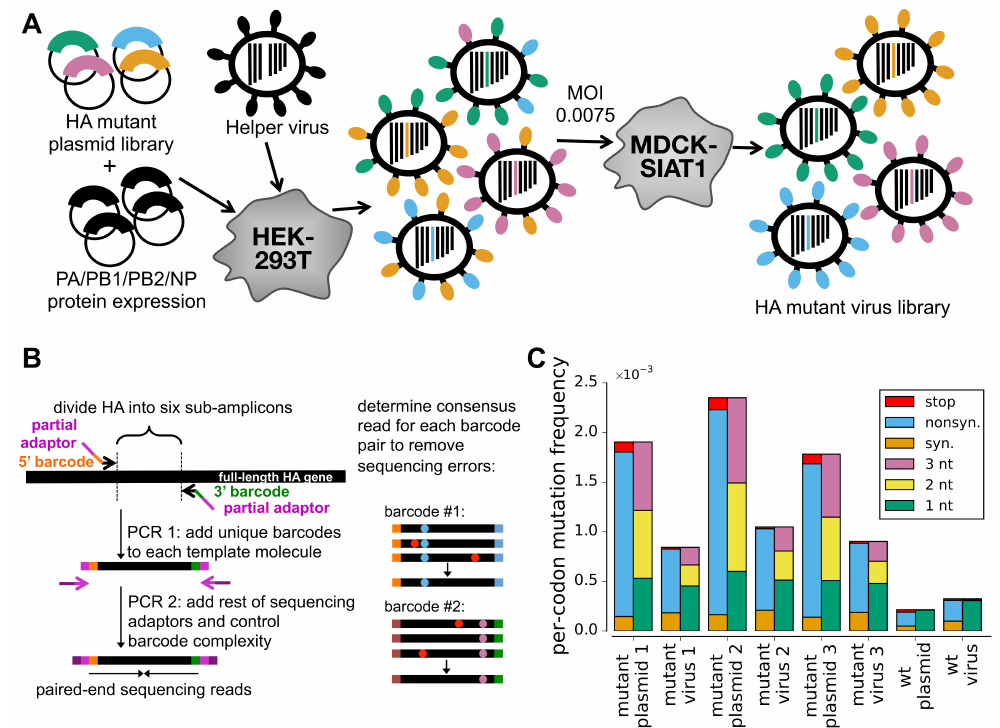
Figure 1. Deep mutational scanning of HA. ( A ) Cells transfected with a plasmid mutant library of HA are infected with an HA-deficient helper virus to yield a library of mutant viruses. This virus library is passaged at low MOI to select for functional variants and enforce genotype-phenotype linkage. The helper viruses themselves are propagated in cells constitutively expressing HA (Figure S1). The variants in the plasmid mutant library contain an average of one codon mutation, with the number of mutations per clone following a roughly Poisson distribution (Figure S2). The helper-virus works best when HA is provided on a plasmid that directs the synthesis of only viral RNA (Figure S3). ( B ) Accurate Illumina sequencing using barcoded subamplicons. HA is divided into